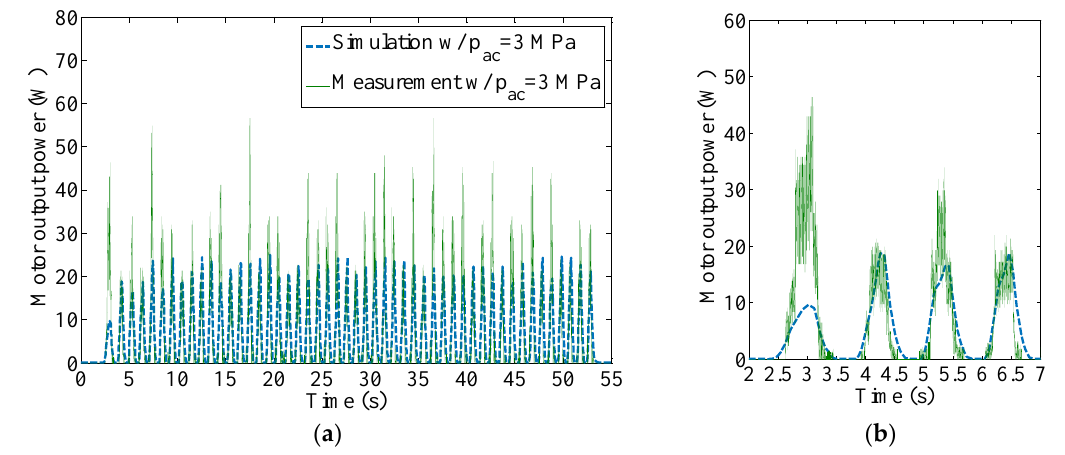
Figure 10. Simulated and experimental results on the hydraulic output power when the accumulator is pre-charged to 3 MPa and is always connected to the motor (i.e., the digital on-off valve is kept energized the entire time during the experiment): ( a ) Full 50-cycle comparison, and ( b ) zoomed-in 4- cycle result timed from 2 s to 7 s for clarity.